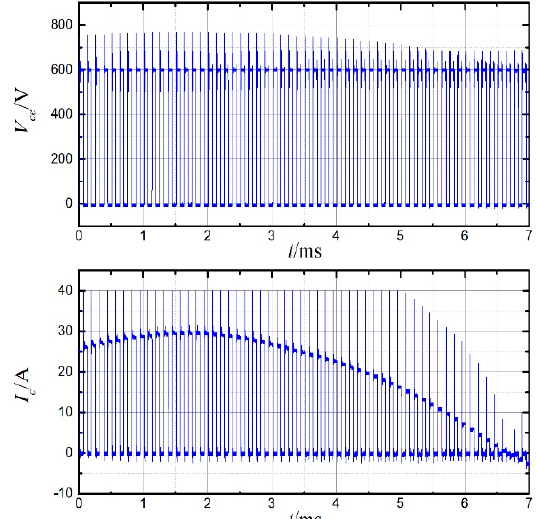
Figure 11. Experimental waveforms of V CE and I C in the PWM converter test.